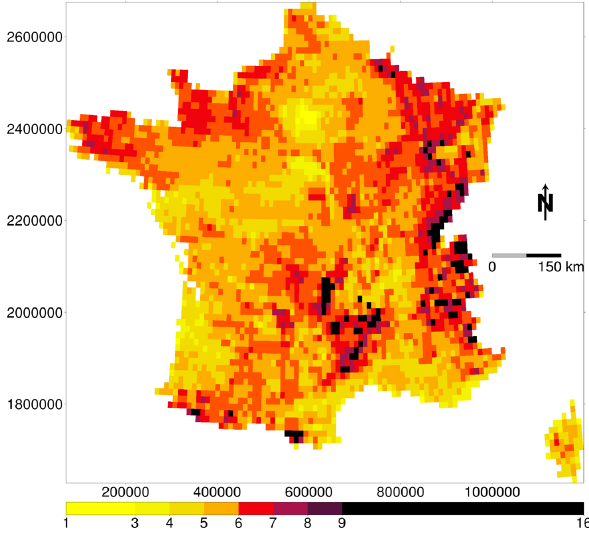
Fig. 5. Map of the soil organic carbon for the first 30cm (kgm − 2